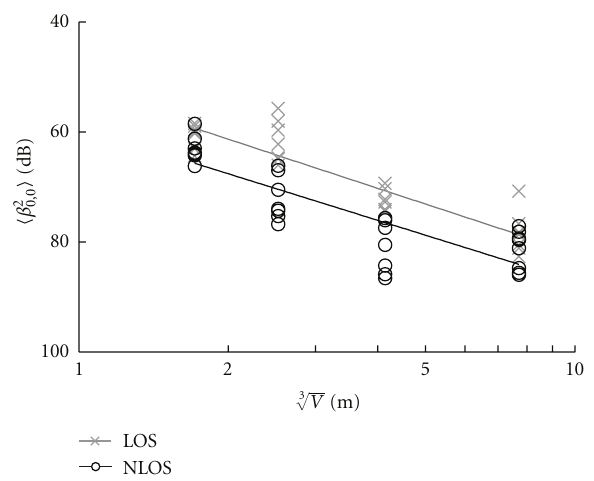
Figure 7: UWB propagation loss of the first ray within the first cluster against V 1 / 3 .